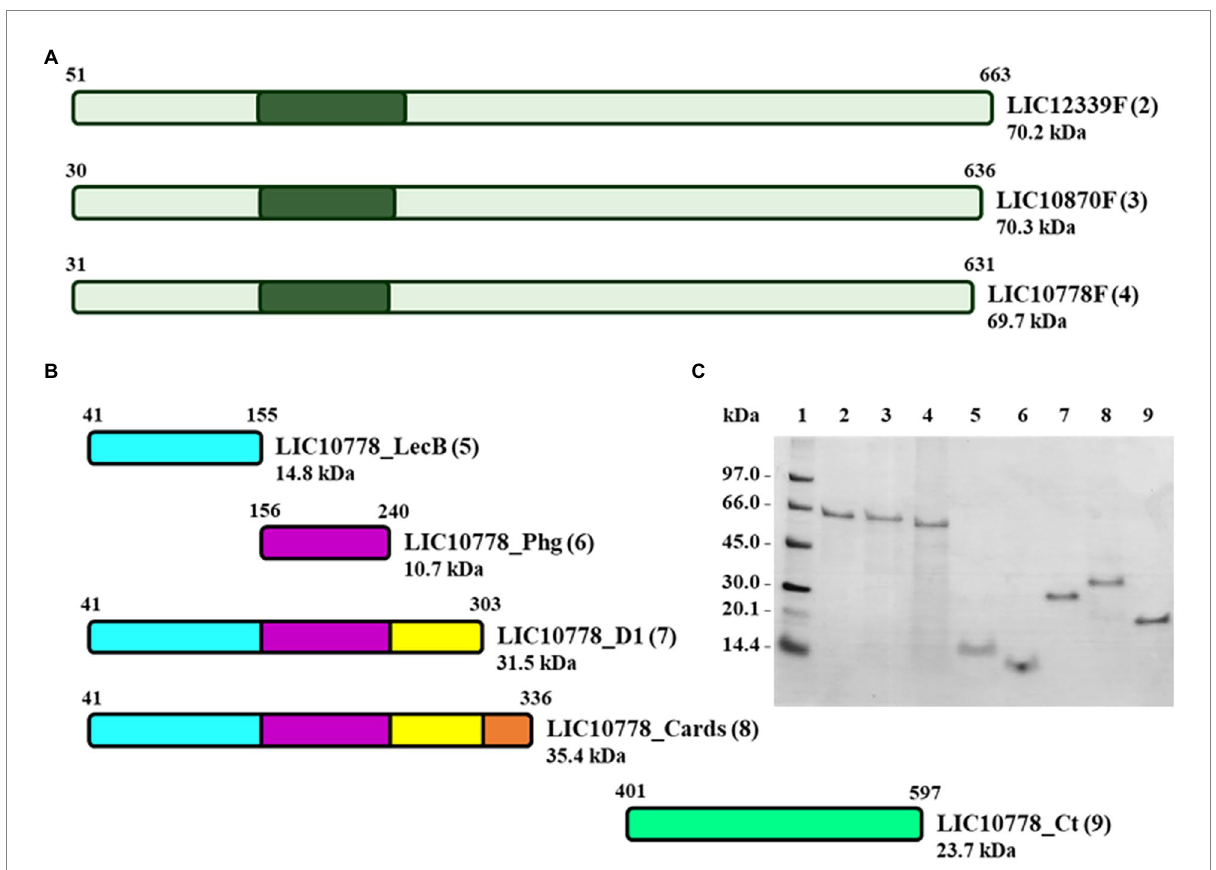
FIGURE 4 Recombinant proteins of PF07598 protein family members LIC10778, LIC10870, and LIC12339. (A) Scheme of the full-length recombinant proteins corresponding to LIC12339, LIC10870, and LIC10778 protein sequences (LIC12339F, LIC10870F, and LIC10778F, respectively). Dark green areas represent the location of the sequence identified by phage display. (B) Scheme of five recombinant proteins of LIC10778, designed from the three-dimensional models generated by prediction programs and identified by the following suffixes: _LecB, referring to the lectin B domain; _ Phg, referring to the sequence identified by phage display; _D1, referring to the N-terminal domain delimited by the Phyre2 server; _Cards, referring to the sequence aligned to the CARDS toxin of M. pneumoniae ; _Ct, referring to the C-terminal region of the protein. (C) SDS-PAGE with the recombinant proteins purified by IMAC in 8 M urea or 6 M guanidine hydrochloride solutions. Proteins were applied in lanes 2 to 9, the same numbers as in each protein scheme shown in panels A and B (numbers in parentheses). Lane 1: molecular mass marker. SDS-PAGE with 16% plus 9% polyacrylamide gel followed by Coomassie Blue